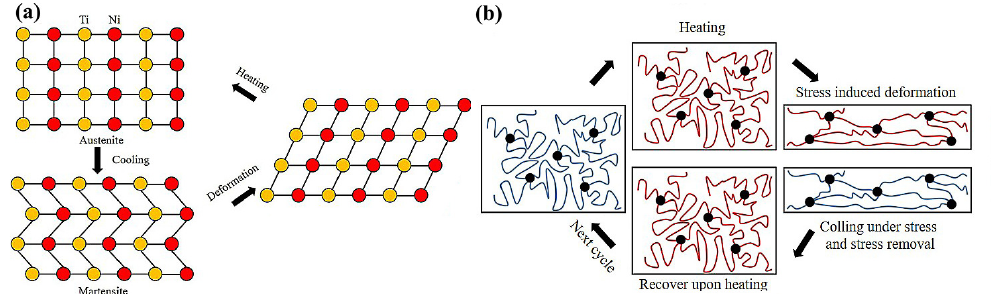
Figure 2. ( a ) The crystal structure variation of nickel titanium (Ni-Ti) SMA. ( b ) Schematic diagram of SMP